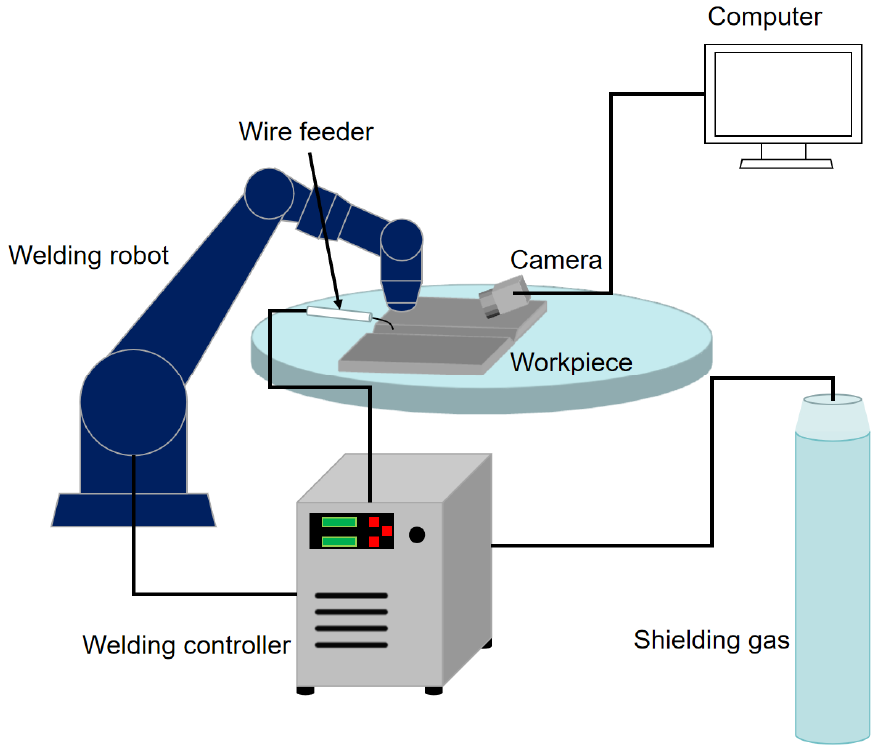
Figure 1. State of the system during welding.